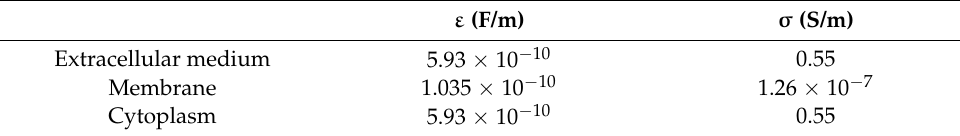
Table 1. Dielectric properties of cell